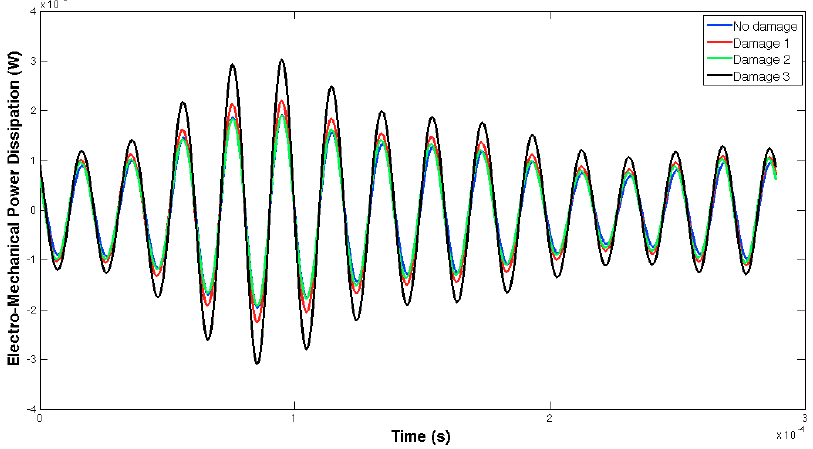
Figure 12. Damage scenario for an FRP-strengthened concrete specimen (II).